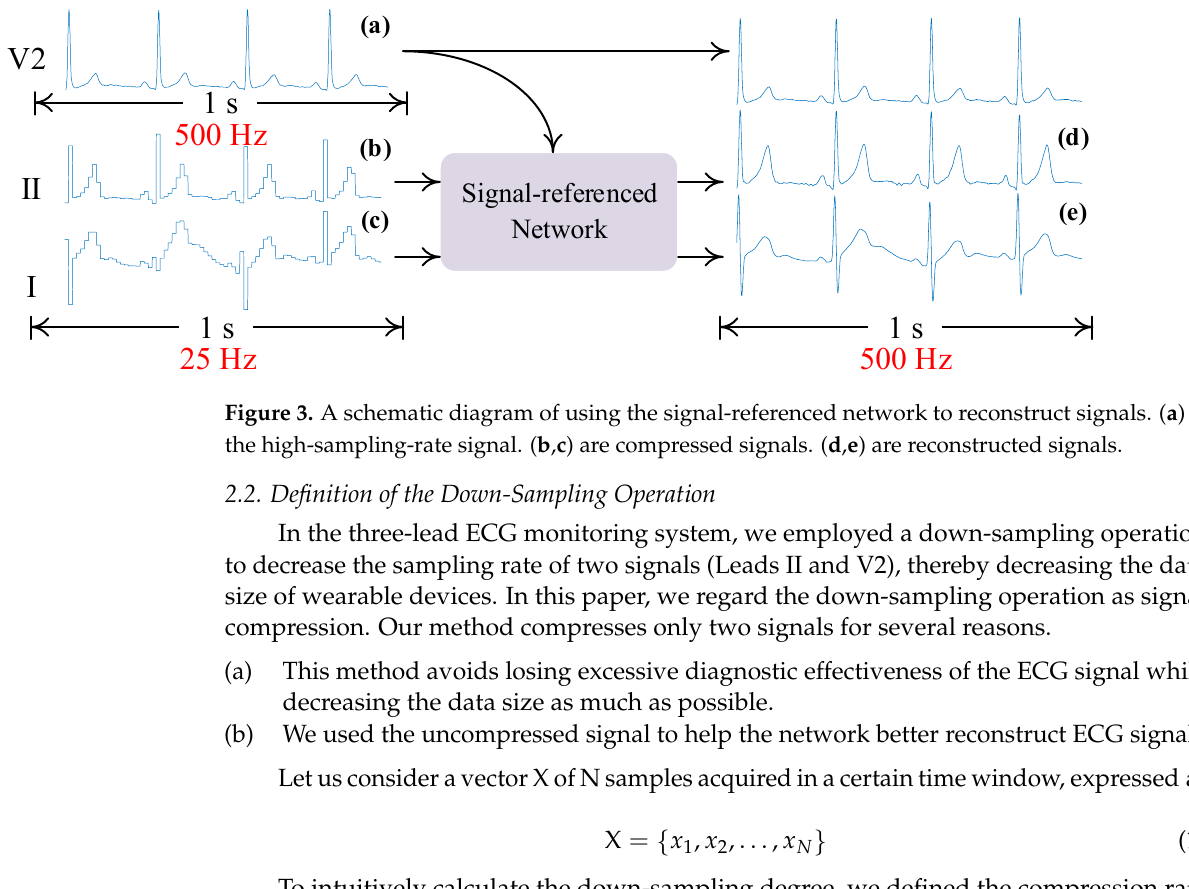
Figure 3. A schematic diagram of using the signal-referenced network to reconstruct signals. ( a ) is the high-sampling-rate signal. ( b , c ) are compressed signals. ( d , e ) are reconstructed signals.